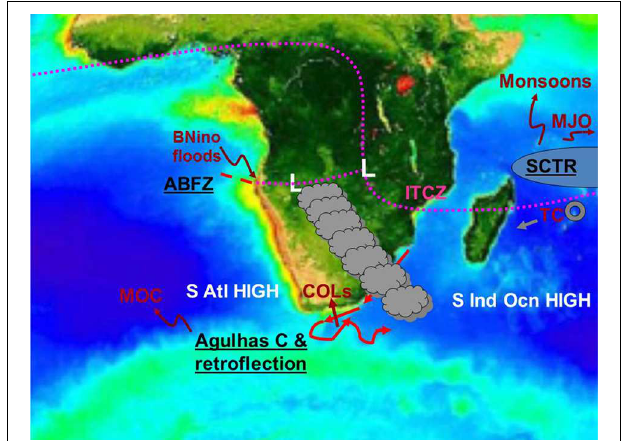
FIGURE 1 | Schematic showing the main circulation features important for southern African rainfall during summer (Angola low denoted L, subtropical anticyclones, tropical convergence zones denoted as magenta dotted lines, cloud bands), unique regional oceanic features (Angola Benguela Frontal Zone denoted ABFZ, Agulhas Current and retroflection region, Seychelles-Chagos Thermocline Ridge denoted SCTR) and their climate impacts (Meridional Overturning Circulation denoted MOC, cut-off low induced flooding denoted COLs, tropical cyclones denoted TC, Madden Julian Oscillations denoted MJO, Benguela Niño induced floods denoted